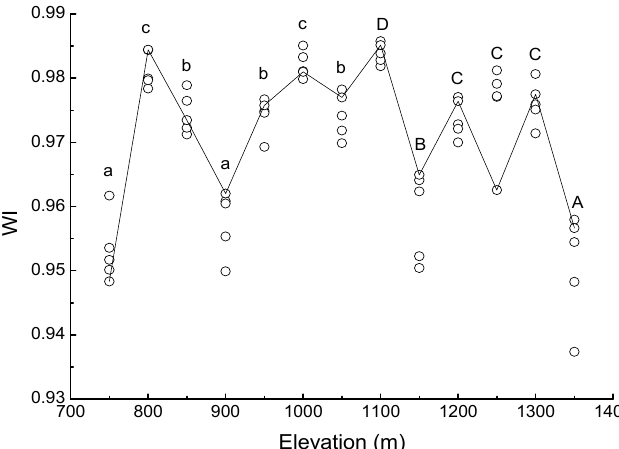
Figure 3. Scatter plot of water band index (WI) of needles in Pinus koraiensis at each elevation on Changbai Mountain. For each elevation, the sample size was 5. Lowercase letters denote significant differences among elevations in PBMF ( Pinus koraiensis and mixed broadleaved forests). Uppercase letters denote significant differences in ECF (evergreen coniferous forests) (both at the p < 0.05 level). Differences in LMA among the populations from different elevations were not significant ( p > 0.05), either in PBMF or in ECF. LMA was also observed to be not significantly ( p > 0.05) affected by forest type; mean values were 58.8 and 59.5 g · m − 2 in PBMF and ECF, respectively (Figure 4).